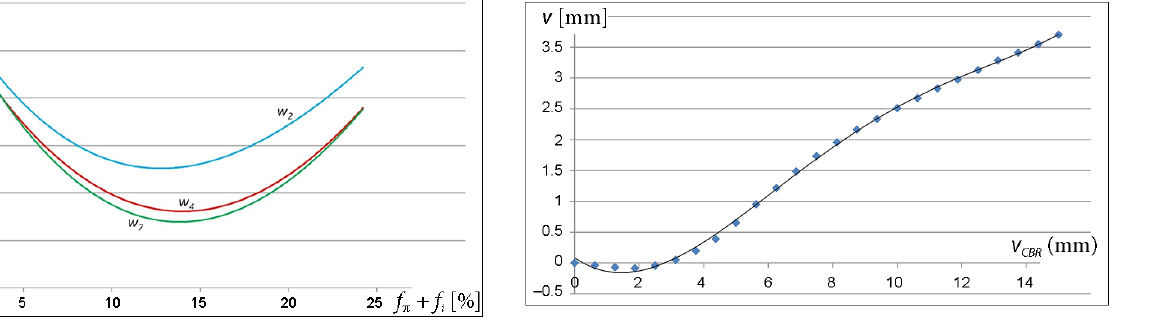
Figure 15. The dependence between the indentation of the press piston v CBR and the displacement of annular surcharge rings